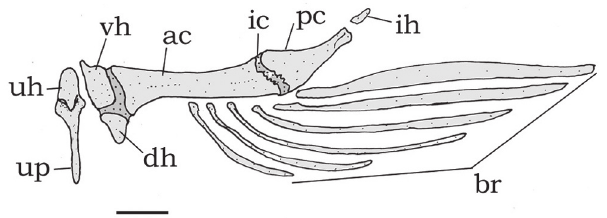
Fig. 4. Right hyoid arch of Centromochlus britskii , MZUSP 43251, paratype, 35.9 mm SL. Ventral view. Abbreviations: ac , anterior ceratohyal; br , branchiostegal rays; dh , dorsal hypohyal; ic , interceratohyal cartilage; ih , interhyal; pc , posterior ceratohyal; vh , ventral hypohyal; uh , urohyal; up, urohyal ventral process. Scale bar = 1 mm.